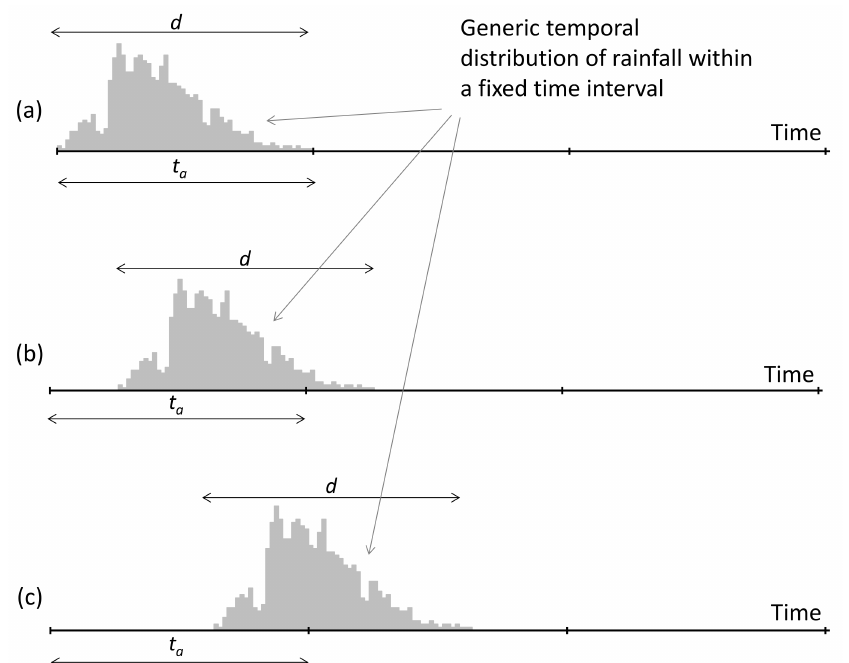
Figure 7. Schematic representation of a generic temporal distribution of rainfall with duration d = t a : ( a ) condition where a correct evaluation of H d is possible; ( b ) condition with a generic underestimate of H d ; ( c ) condition with the maximum underestimate of H d (equal to 50%). t a and H d denote the temporal aggregation and annual maximum rainfall rate of duration d ,